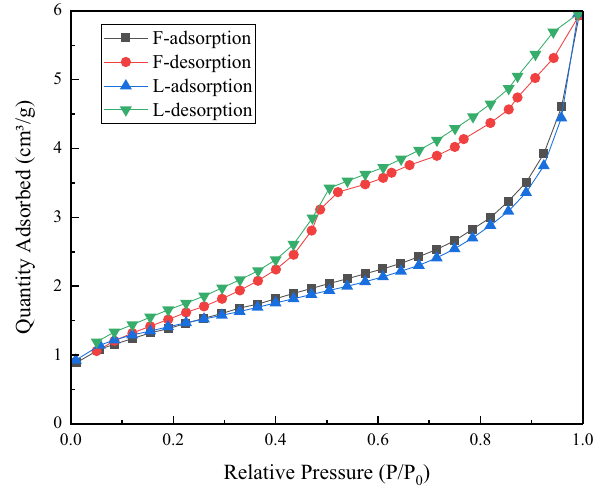
Fig. 2 Low-temperature N